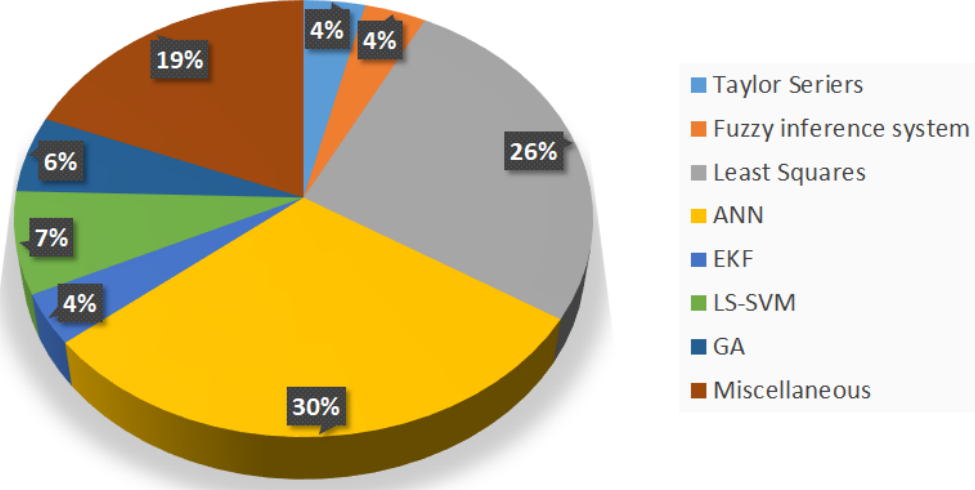
Figure 4. Percentage share of black-box (BB) methods used in the GB design.